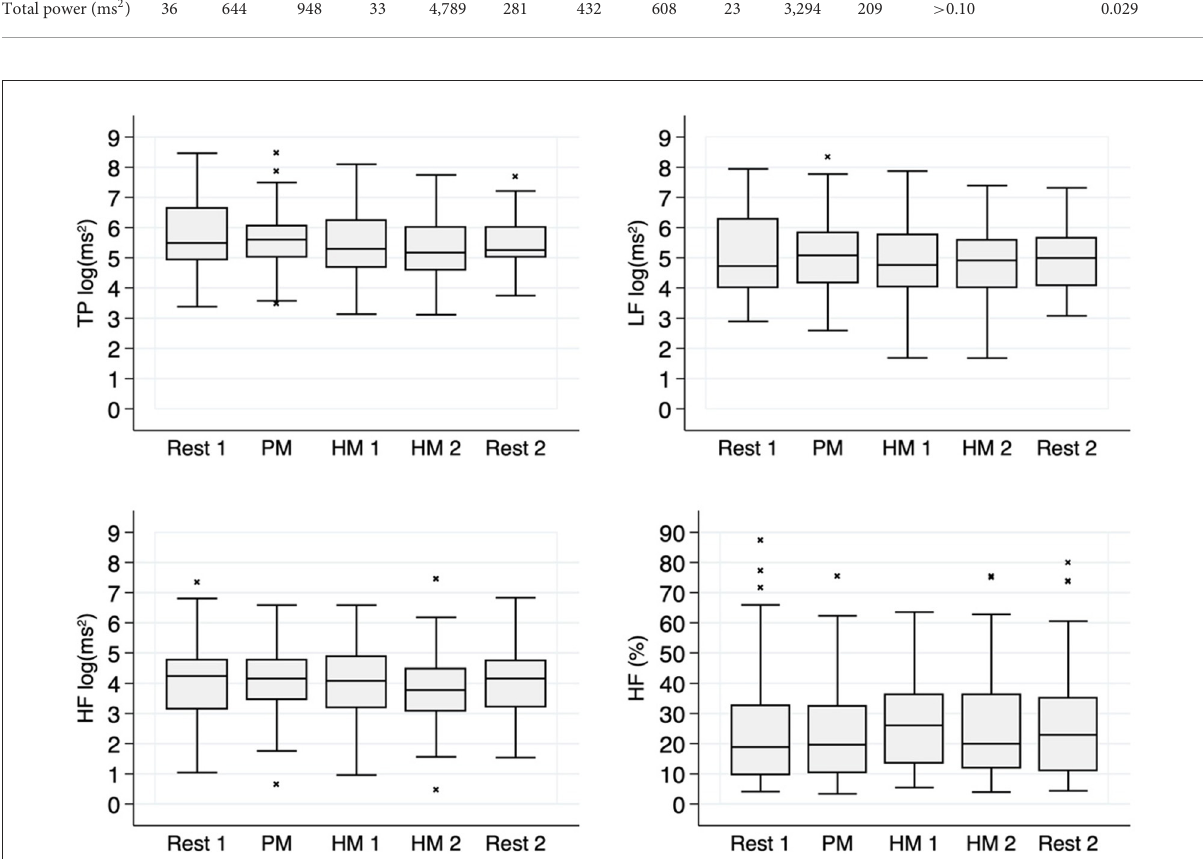
FIGURE3 HRV-Parameter from frequency domain: Rest: Resting period before (1; N = 37) and after (2; N = 37) music, PM: Pain Music ( N = 37), HM: Healing Music first 2min (1; N = 36) and last 2min (2; N = 36). The sample size differs due to a shorter duration of HM in one